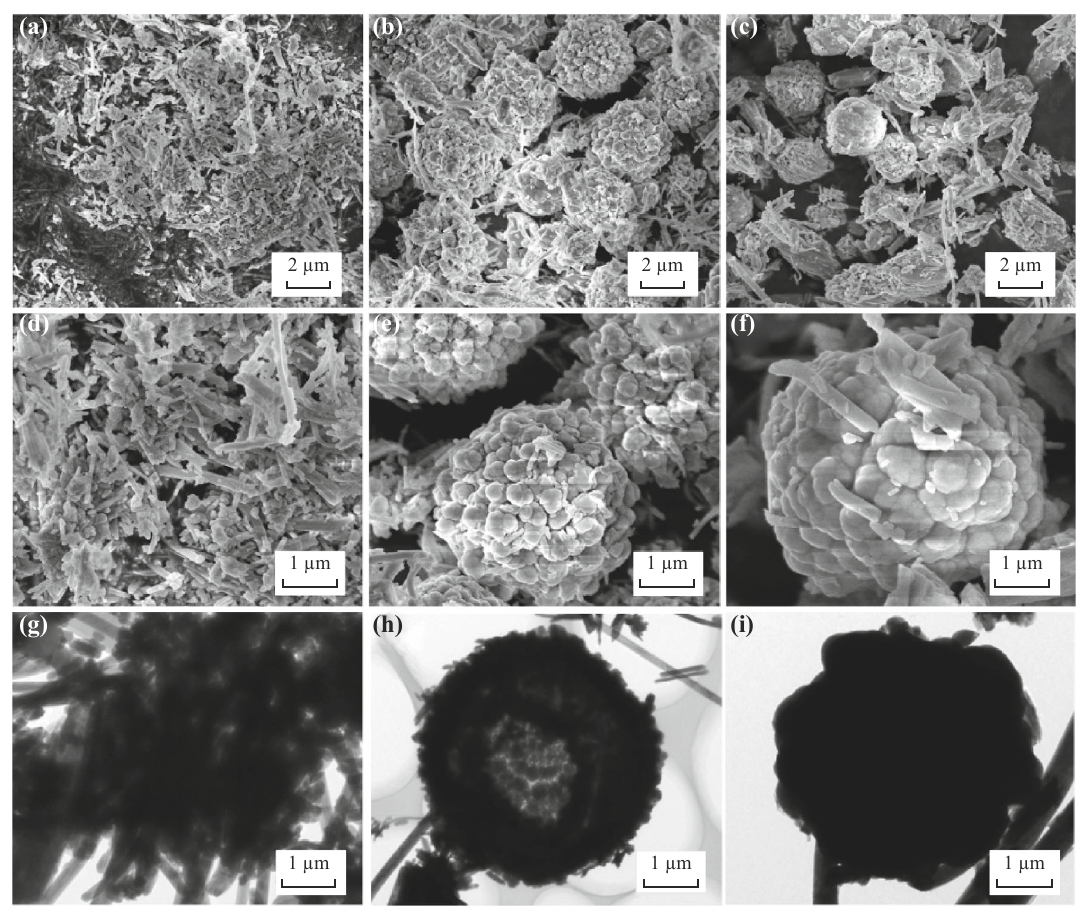
Fig. 2 a - f FIB-SEM and g - i TEM images of a , d , g Sb 2 S 3 -120, b , e , h Sb 2 S 3 -150, and c , f , i Sb 2 S 3 -180